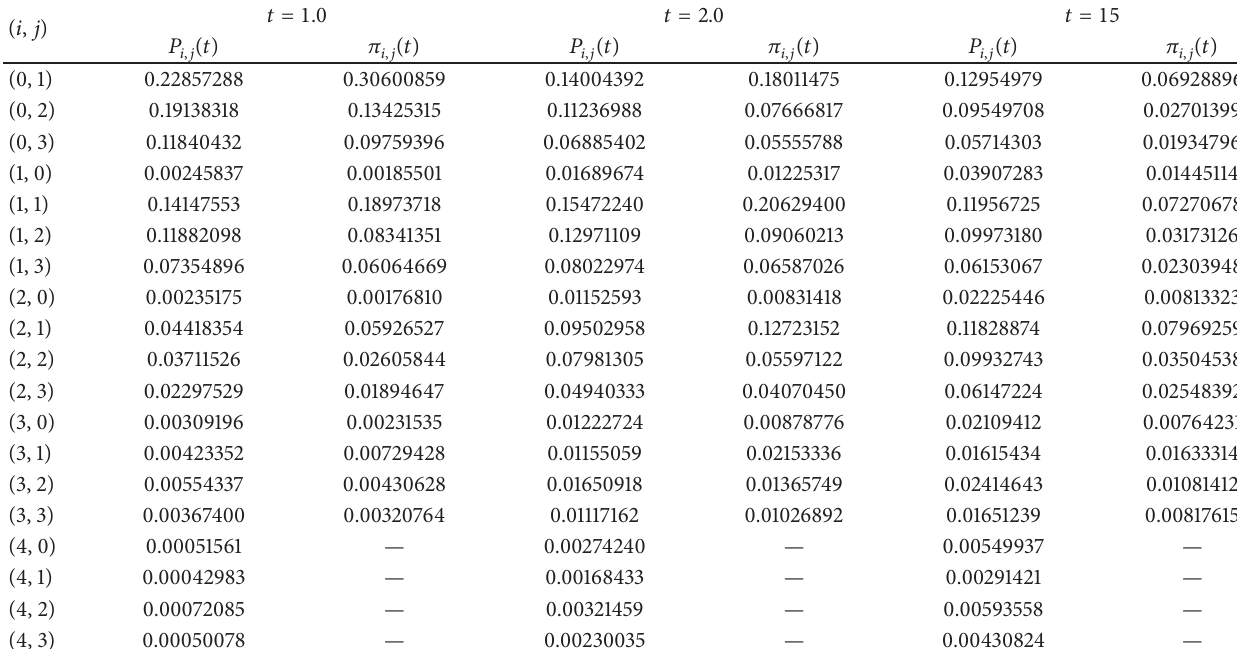
Table 4: State probabilities at time 𝑡 for 6-out-of-9: 𝐺 system with 𝑤 = 1.5 .